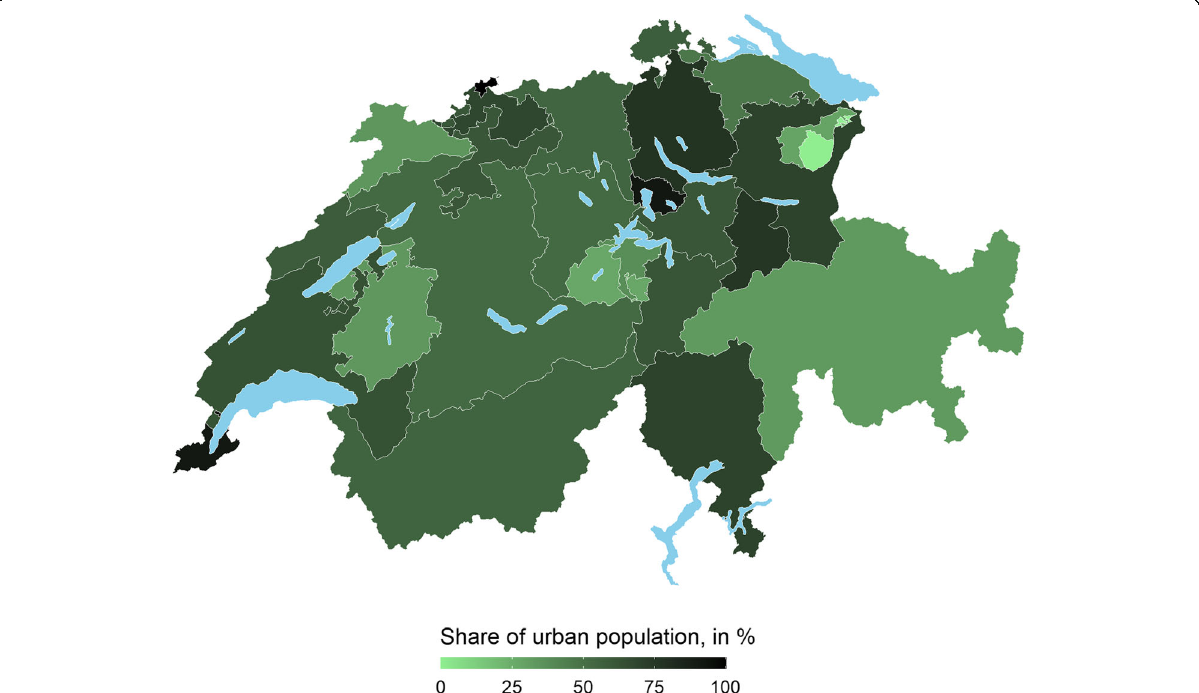
Fig. 11 Swiss cantons and their urbanization degrees. Measured as the percentage of residents living in urban municipalities. Source: Own calculations,